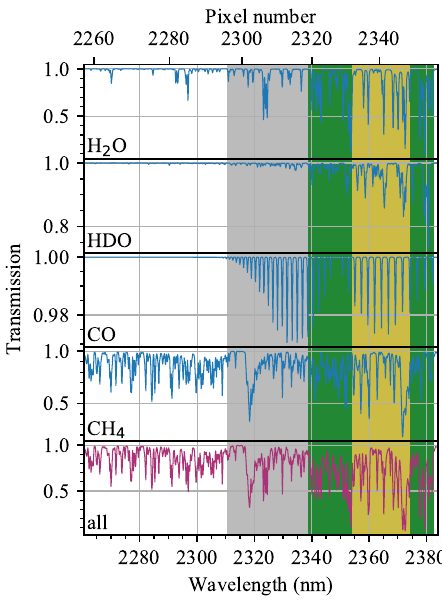
Figure 1. Simulation of atmospheric absorption in the spectral range of SCIAMACHY’s channel 8 for the absorbers taken into account by the retrieval algorithm. The grey shading marks the re- trieval window for CO used by Borsdorff et al. (2016, 2017), the yel- low shading marks the window for H 2 O and HDO used by Scheep- maker et al. (2015) and the green shading marks the extension of that window used in this work.